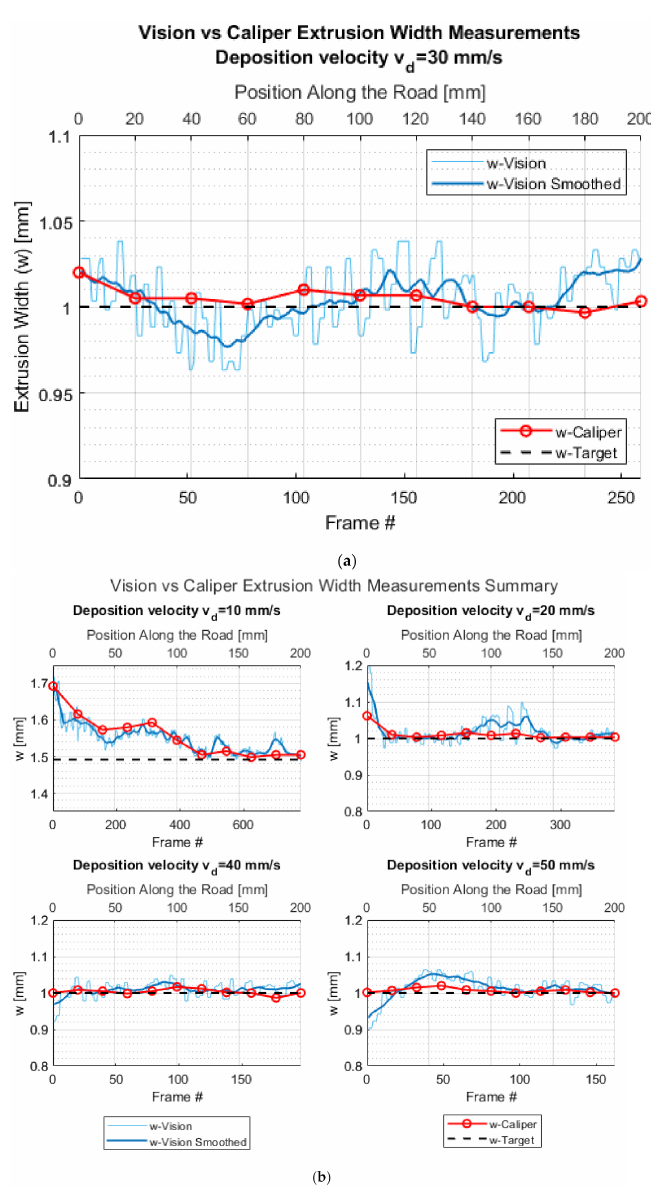
Figure 10. Validation of the vision-based extrusion width measurements with caliper-based measure- ments for various deposition speeds ( a ) 30 mm/s, ( b ) Summary of measurements for 10, 20, 40 and 50 mm/s. Note: w-Target is the designed wall